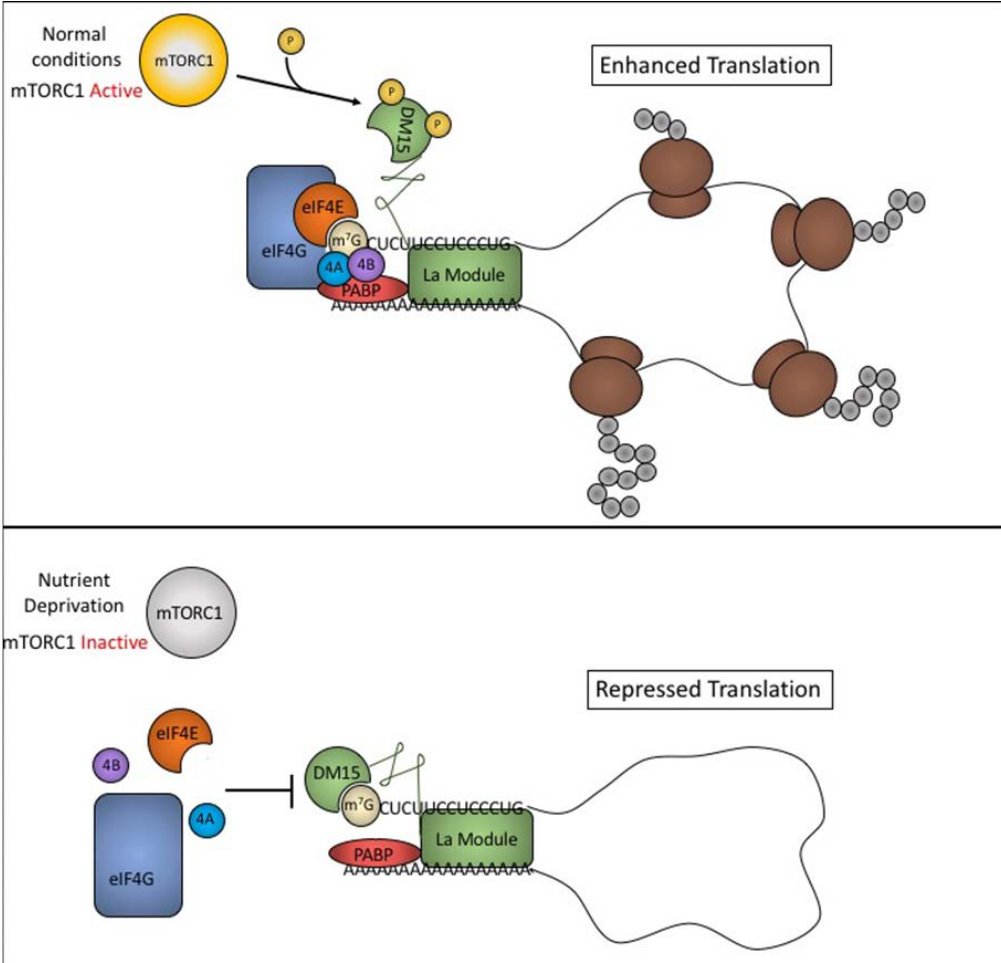
Figure 3. LARP1 regulates translation of 5’ TOP motif containing transcripts. Upper panel: Under normal nutrient conditions, the DM15 domain of LARP1 is unable to bind to the m7G cap allowing eIF4E binding, eIF4F assembly, and procession of translation initiation. The La module of LARP1 binds to the poly(A) tail, PABP, and the 5’ TOP motif in a cap independent manner. These interactions promote circularization of the TOP transcript and enhance translation. Lower panel: Nutrient deprivation leads to inactivation of mTORC1 and hypophosphorylation of residues in or near the DM15 domain allowing it to bind to the 5’ TOP motif and the m7G cap. DM15 blocks interactions of eIF4E with the cap and halts the downstream steps required for cap-dependent translation initiation thereby repressing